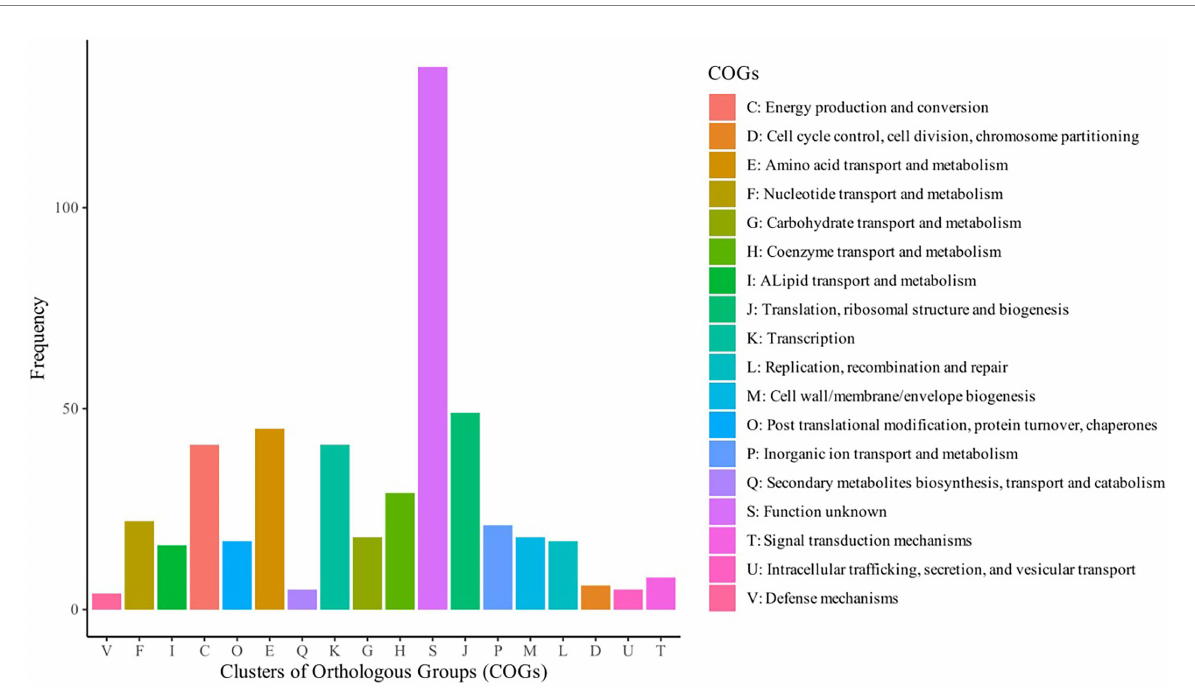
FIGURE 2 Category of Clusters of Orthologous Groups (COG) of genes central to the genomes of 248 Staphylococcus aureus isolated from humans (abscesses, skin infections and pus) and from cattle (clinical mastitis, subclinical mastitis and raw